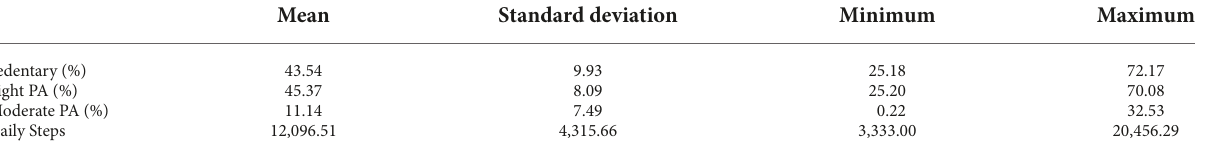
TABLE 2 Physical activity characteristics ( N = 71).